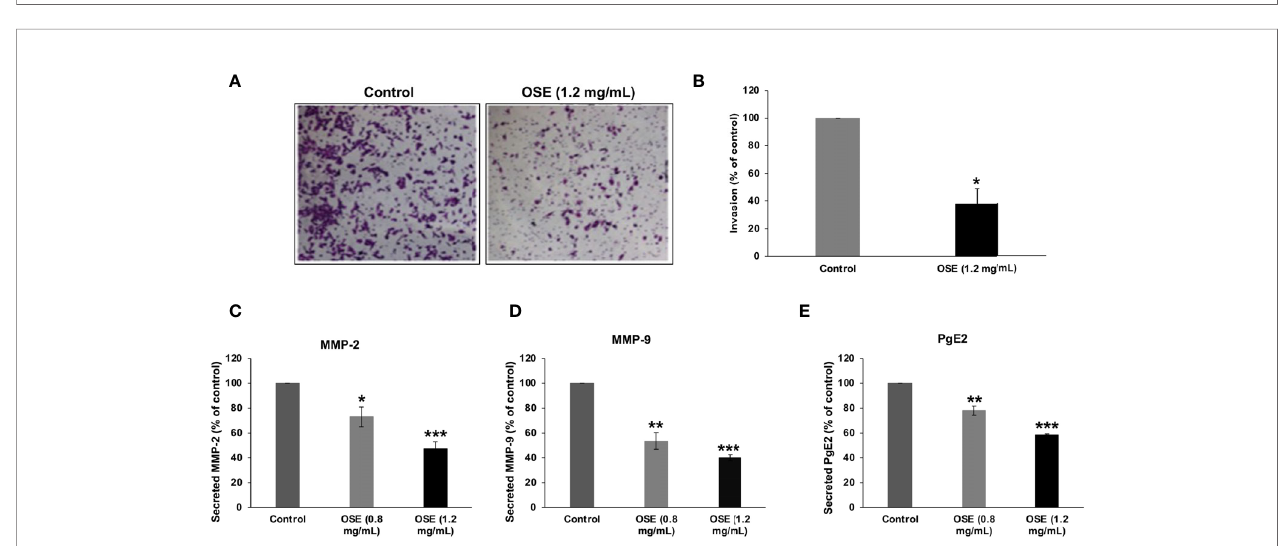
FIGURE 6 | OSE inhibits invasion and downregulates MMP-2, MMP-9 and PgE2 in MDA-MB-231 cells. (A, B) Cells were treated with OSE (1.2 mg/ml) and cell invasion was evaluated using invasion assay as described in materials and methods. Representative photomicrographs show the effect of OSE on invading cells. (C – E) Cells were grown in with (0.8 and 1.2 mg/mL) or without OSE. Levels of secreted MMP-2 (C) , MMP-9 (D) , and PgE2 (E) were evaluated by ELISA as described in material and methods. Values are represented as mean ± standard error of the mean (SEM) of three independent experiments (*p < 0.05, **p < 0.005, ***p <